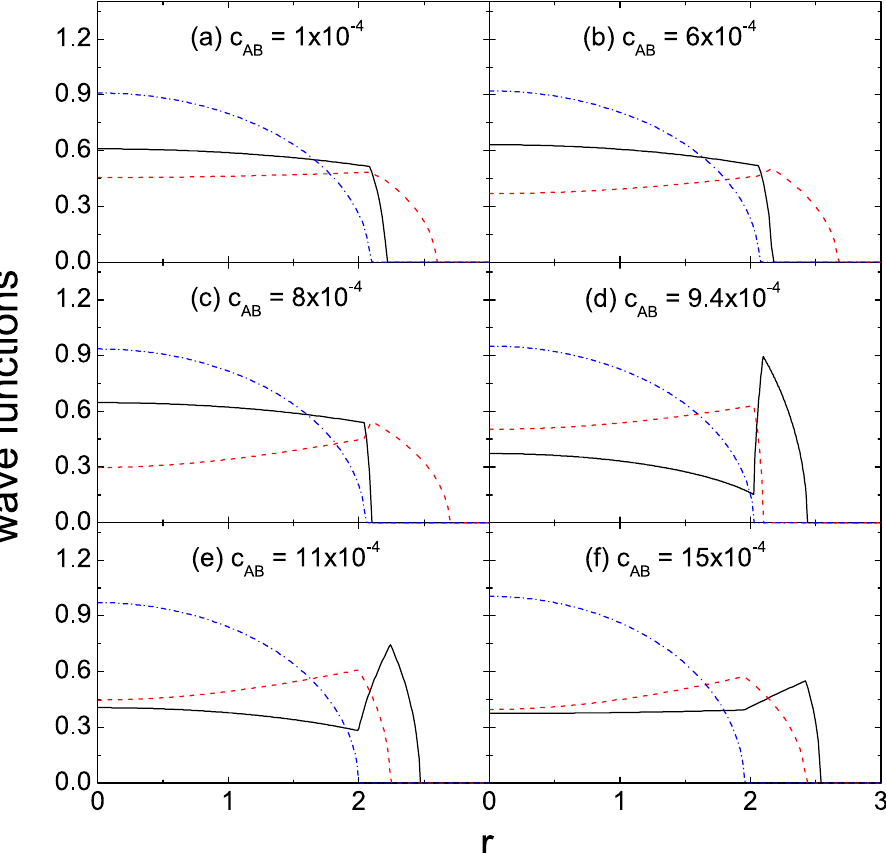
Figure 2. The same as in Fig. 1 but the parameters are so given that p BC and p CA are in opposite signs. The details of parameters are N A = N B = N C = 30000, c A = 4 × 10 − 4 (in ħ ωλ 3 , the same in the follows), c B = 2 × 10 − 3 , c C = 1 × 10 − 3 , c BC = 11.5 × 10 − 4 , c CA = 10.5 × 10 − 4 , γ A = γ B = γ C =